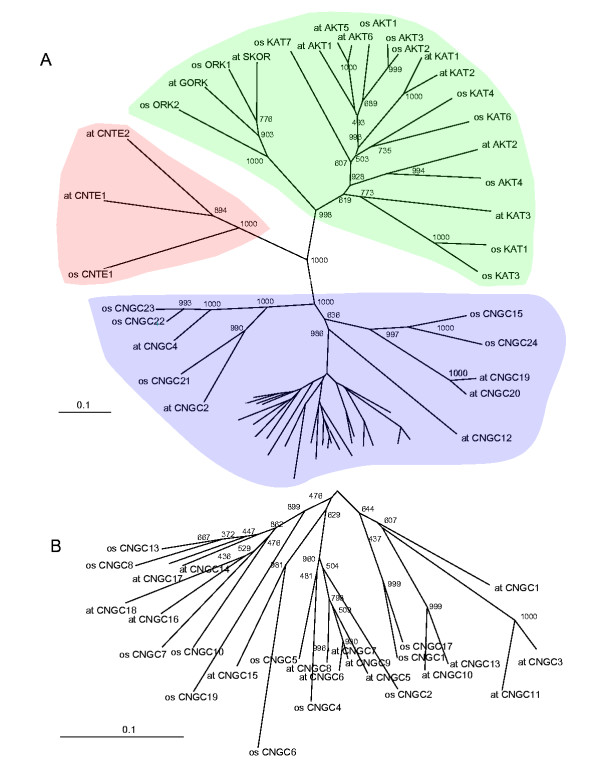
Phylogenetic analysis of plant CNB domains. Un-rooted neighbor-joining tree of CNB domains in Arabidopsis thaliana and Oryza sativa. Shading represents the three classes of CNB domains in plants; shaker-type potassium channels are shown in green, acyl-coA thioesterases are shown in red and CNGC channels are shown in blue. Numbers on the nodes indicate the number of possible trees out of 1000 in which that node was present. Scale represents the number of differences per residue. B) This is an expanded view of the unlabelled region in Figure 3A showing the closely related CNGC proteins more clearly. Tree was generated using ClustalX [65] and visualized using TreeView [68]. See additional file 4 for sequence alignments.